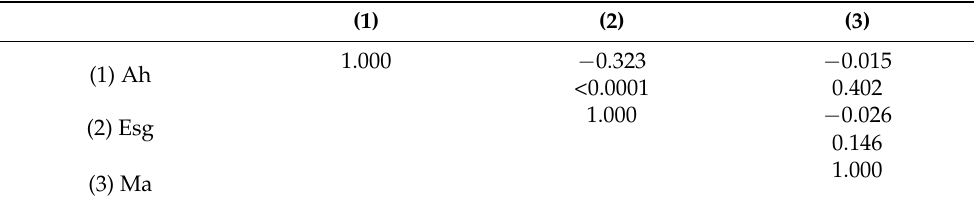
Table 3. Pearson